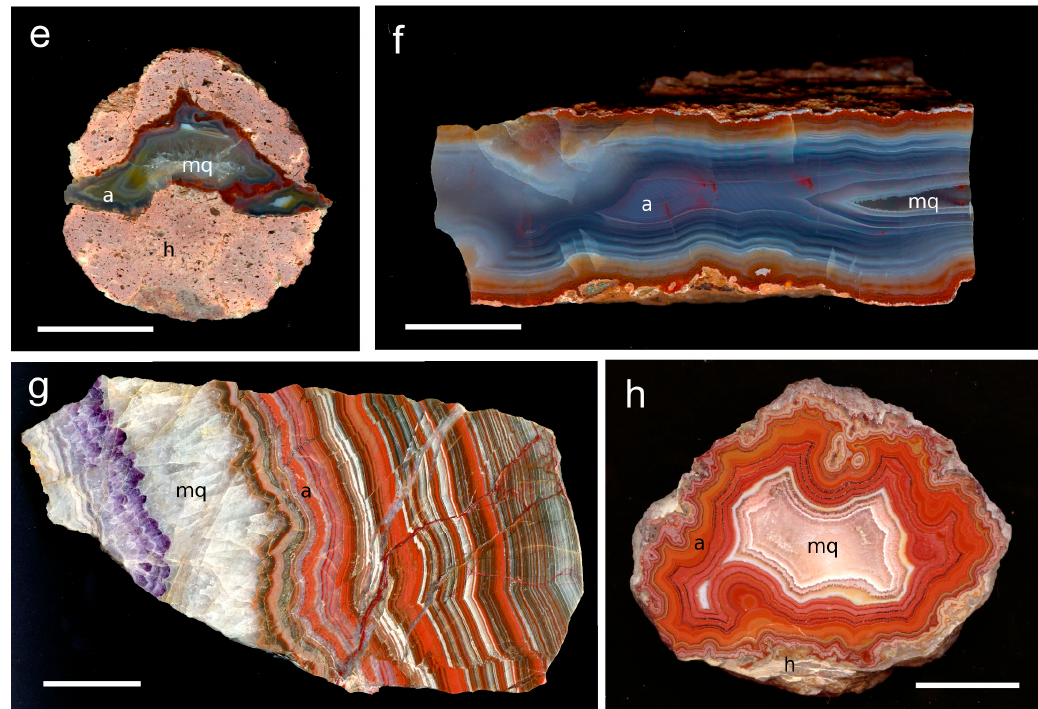
Figure 1. Investigated agate samples of the present study with a = agate, mq = macrocrystalline quartz, h = host rock; ( a ) Soledade, Rio Grande do Sul (Brazil), ( b ) Heads of Ayr, Dunure area (Scotland), ( c ) Zwickau-Planitz, Saxony (Germany), ( d ) St. Egidien, Saxony (Germany), ( e ) Chemnitz-Furth, Saxony (Germany), ( f ) Chemnitz-Altendorf, Saxony (Germany), ( g ) Schlottwitz, Saxony (Germany), ( h ) Dryhead area, Montana (USA); scale bar is 2 cm.